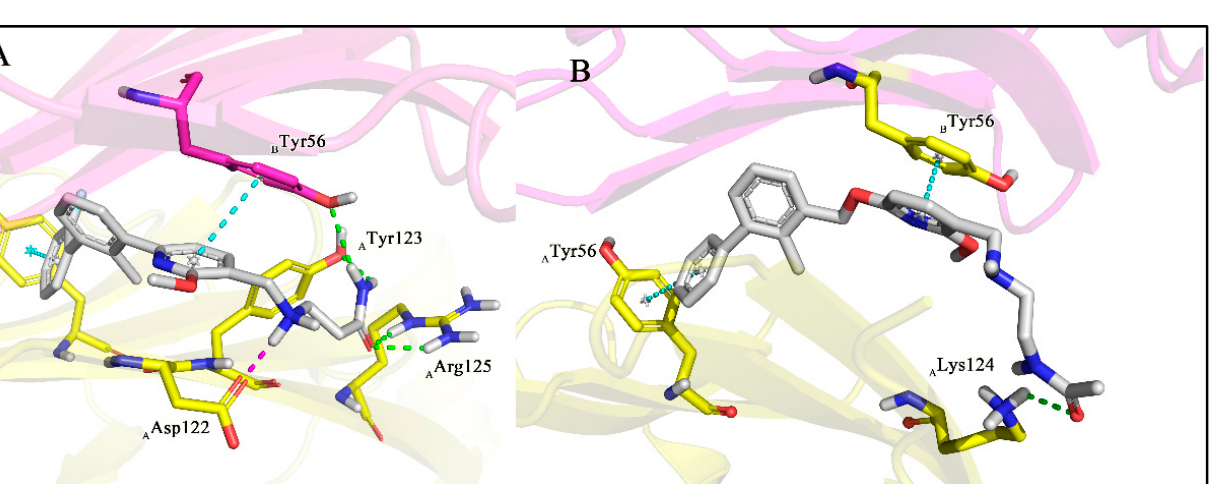
Figure 4. ( A ) Putative binding modes of A9 in the binding pocket of PD-L1 dimer structure (PDB code: 5J89); ( B ) binding modes of BMS-202 in the binding pocket of PD-L1 dimer structure (PDB code: 5J89). Dashed lines represent the inter- interaction between A9 or BMS-202 and protein, specifically, green ones indicate hydrogen bond, purple ones indicate ionic interaction, and sky-blue ones indicate π - π interaction.